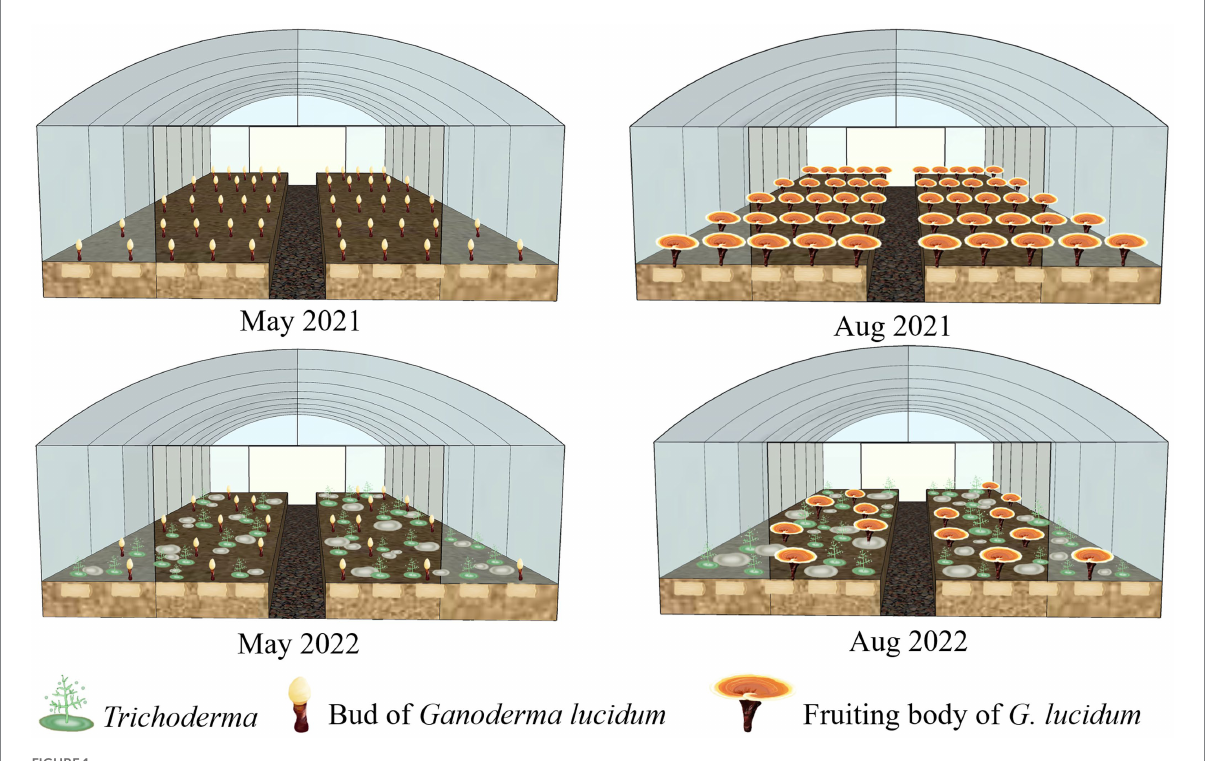
FIGURE 1 An illustrative scheme of Ganoderma lucidum cultivation in Longquan County of China and the sampling